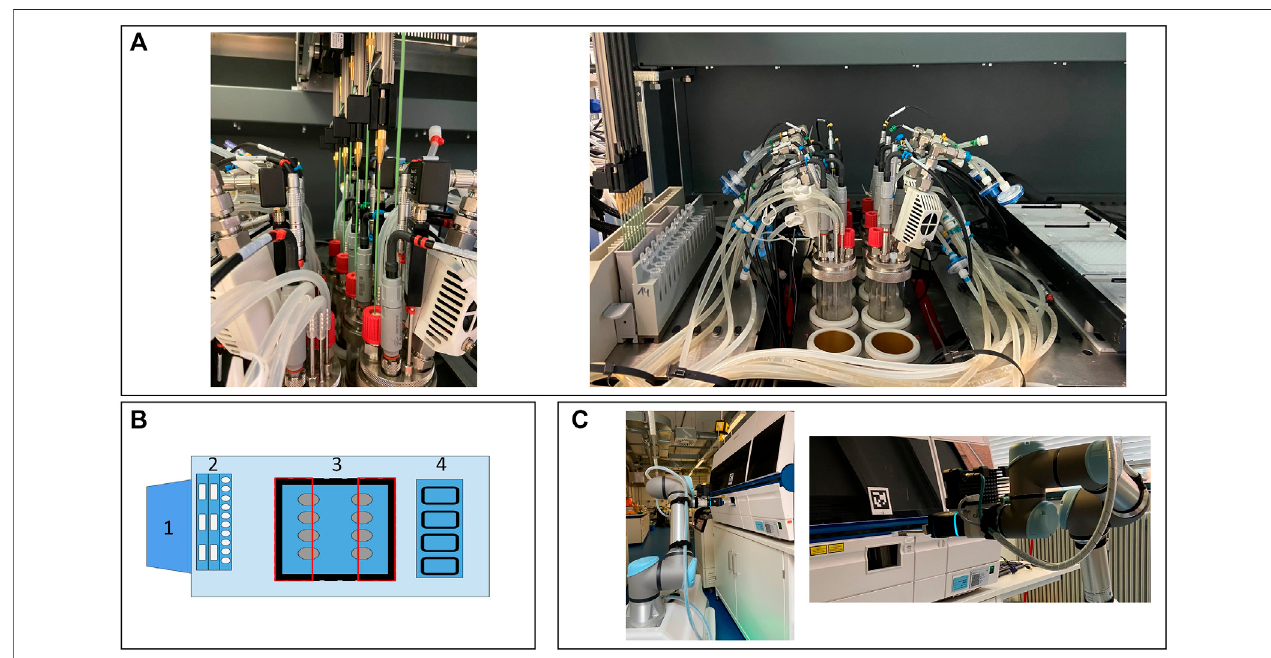
FIGURE 1 | Presentation of the facility. The LHS with the integrated cultivation system (A) . Schematic presentation of the integration and LHS deck layout (B) . 1) Control station for the cultivation system; 2) wash station, troughs, and tube rack; 3) cutout (black), reactor block (blue), and restricted area for the LiHa (red rectangles); and 4) cooling rack for 96-MWP. Mobile robotic lab assistant placing the 96-MWP in the HT analyzer (C) . LHS, Liquid handling station; LiHa, liquid handling arm; MWP, microwell plate; HT, high-throughput.